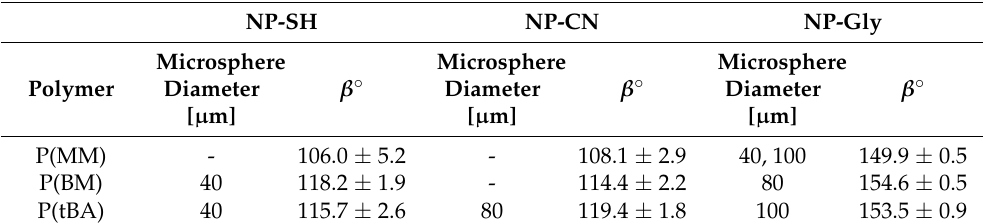
Figure 4. Colloidosome size distribution resulted from Pickering emulsion polymerization obtained from MM, BM, and tBA and stabilized with the NP-Gly. The ultrasonication time for the emulsion was 15 s, for all samples. Table 4. Summary of microsphere diameter and contact angle β with the polymer; the data for NP-CN and NP-SH were taken from reference